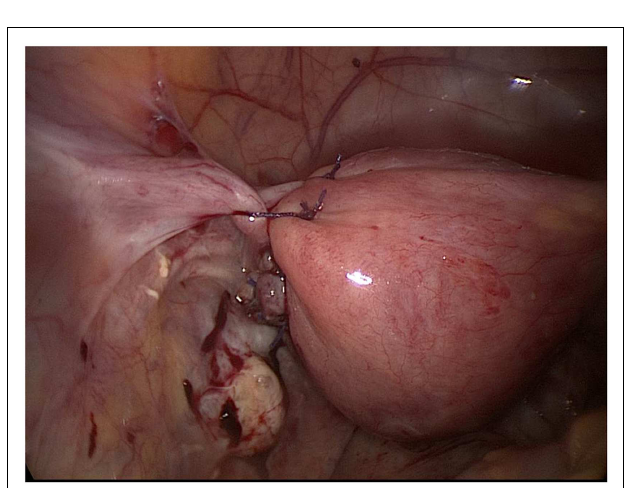
FIGURE 3 | Final result of surgery in case